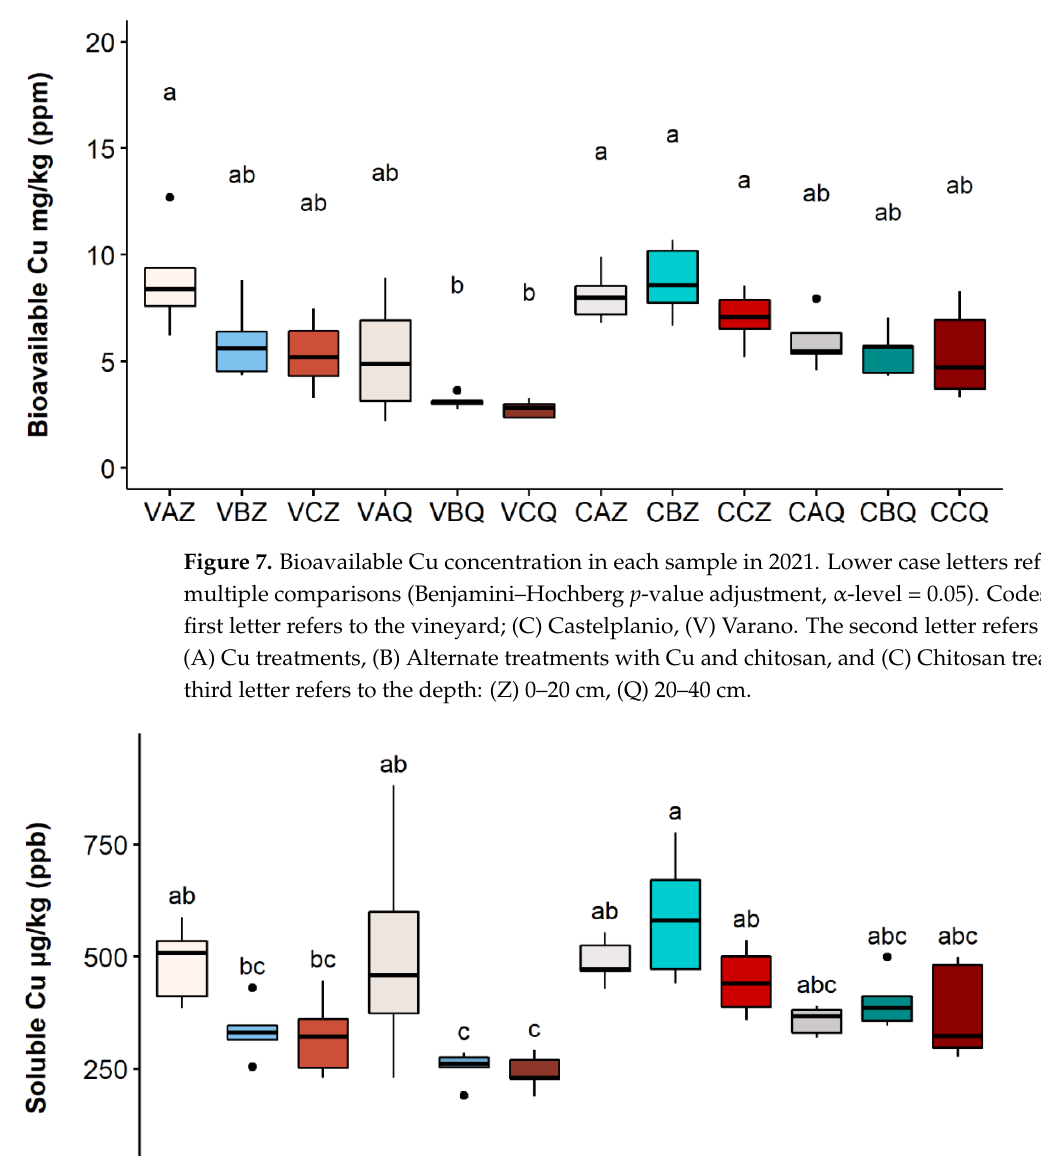
Figure 6. Total Cu concentration in each sample in 2021. Lower case letters refer to Dunn’s multiple comparisons (Benjamini–Hochberg p -value adjustment, α -level = 0.05). Codes legend: the first letter refers to the vineyard; (C) Castelplanio, (V) Varano. The second letter refers to the thesis: (A) Cu treatments, (B) Alternate treatments with Cu and chitosan, and (C) Chitosan treatments. The third letter refers to the depth: (Z) 0–20 cm, (Q) 20–40 cm.